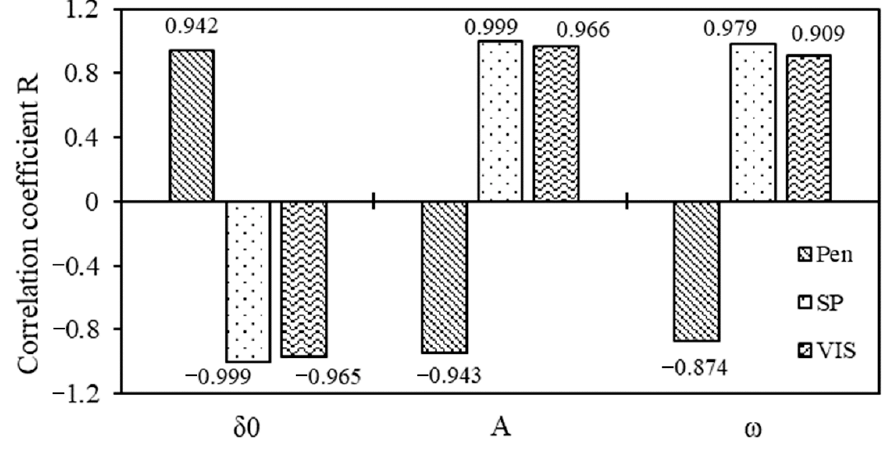
Figure 6. Correlation between master curve parameters of phase angle and asphalt indexes.